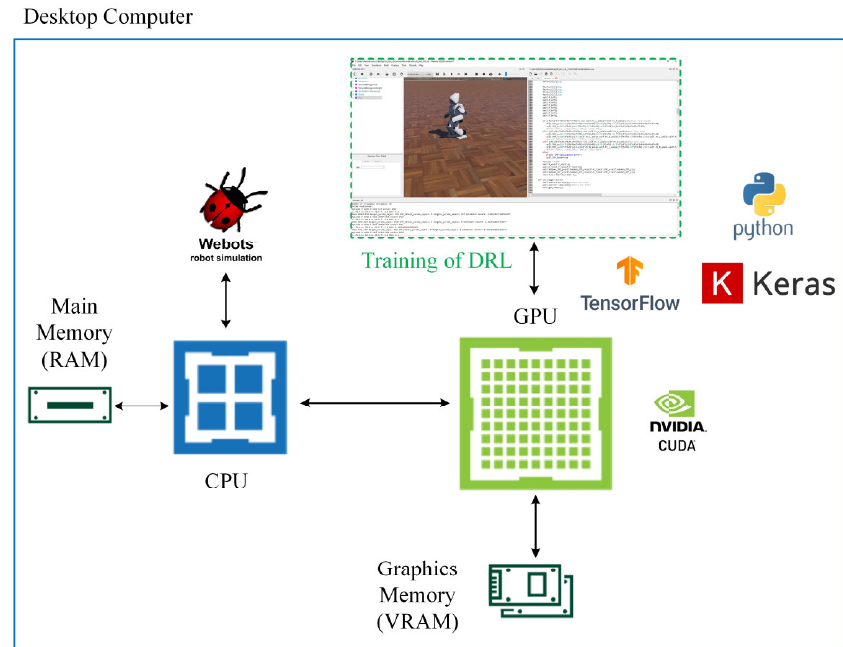
Figure 16. Schematic diagram of the training process with DRL. During the training process, the rewards received in each episode were recorded. Weights were stored in every 100 episodes. After the training was completed, the average reward obtained by taking the average of the last 40 episodes was drawn, and it was ob- served that a highly fluctuating graph appeared. This situation is because training in- cludes too many episodes. The graph obtained by taking the average of the last 200 epi- sodes instead of the last 40 episodes is obtained in Figure 17.